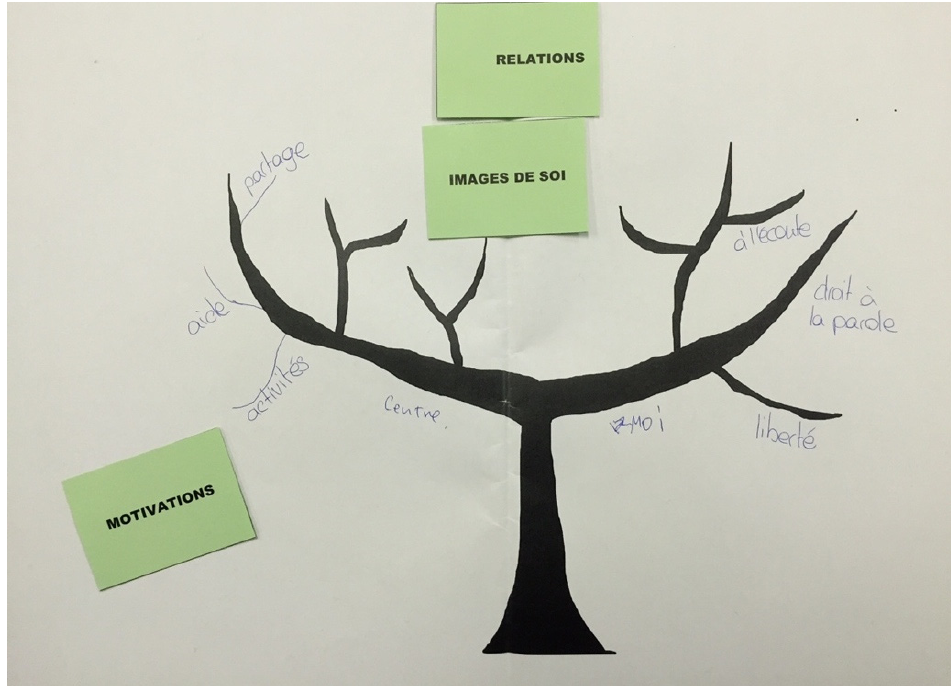
Figure 3. Mind mapping tree for S in C1.